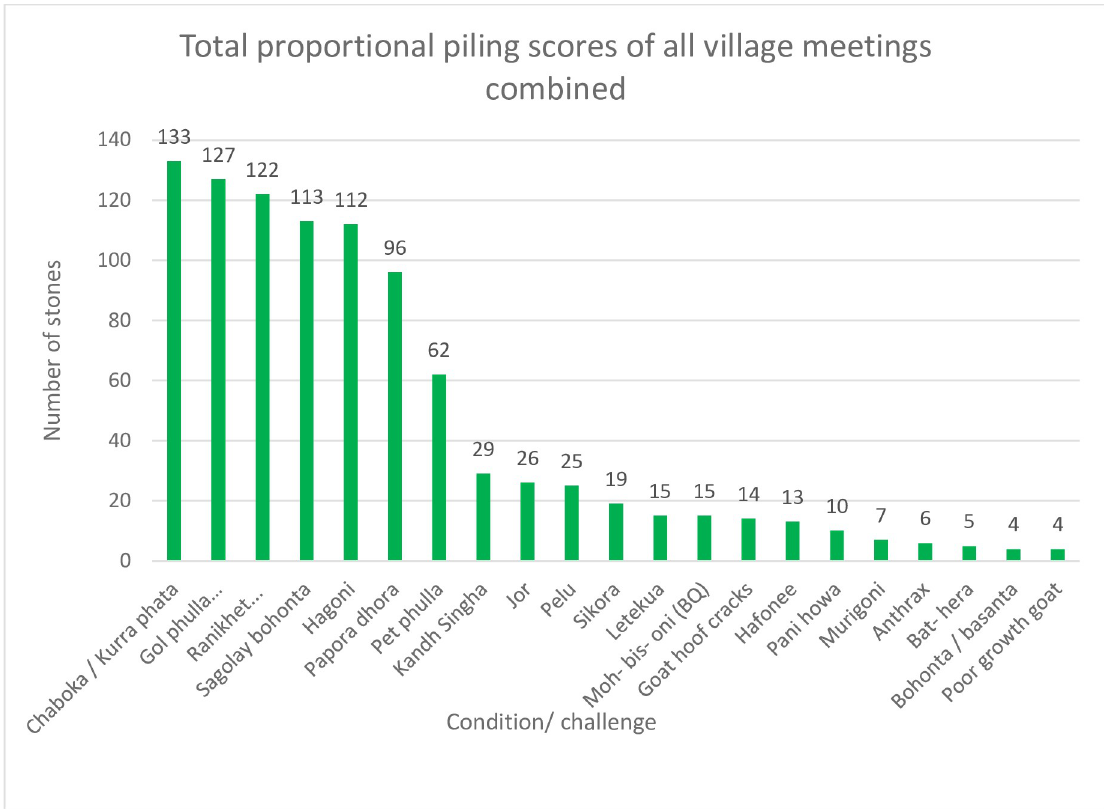
Fig 5. Total of proportion piling scores to indicate the perceived relative importance of animal health conditions for all ten villages combined. Total number of stones used is 1000.